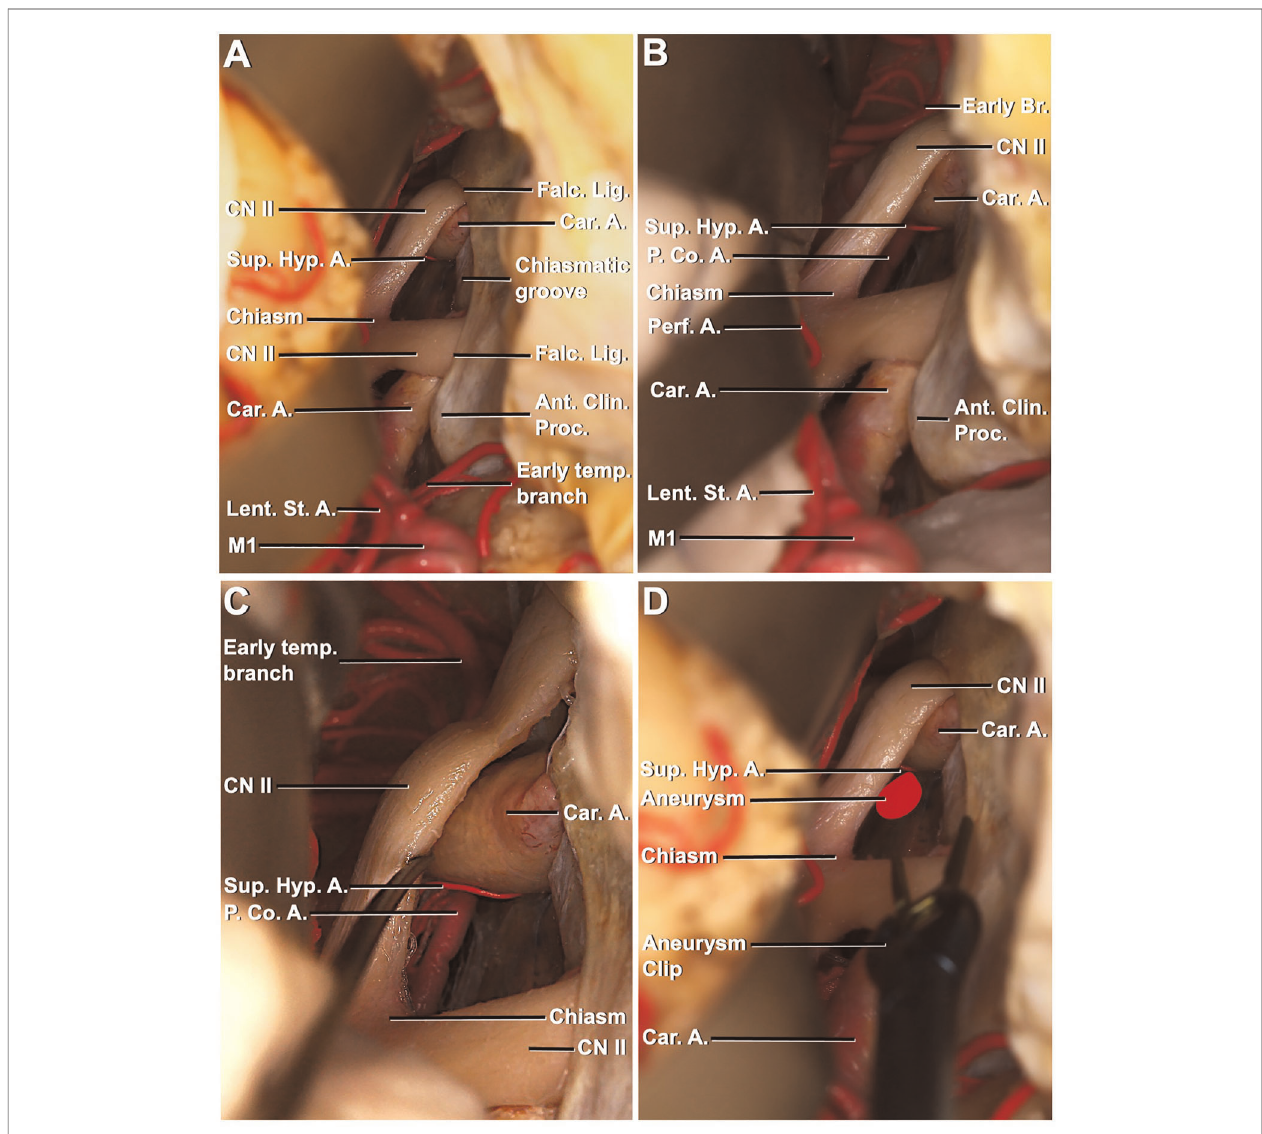
FIGURE 3 | Right pterional exposure of the preoptic chiasm and circle of Willis, contralateral approach to the left superior hypophyseal artery. ( A ) Right frontotemporal bone fl ap is elevated, and the dura is opened. The right frontal and temporal lobes have been retracted to expose the right carotid artery entering the dura medial to the anterior clinoid process. Right – left optic nerves, optic chiasma, prechiasmatic area, left carotid artery, and left superior hypophyseal artery are visible. ( B ) Exposure has been extended between the chiasm and frontal lobe to the left posterior communicating artery (PCoA) left superior hypophyseal artery arising from the ophthalmic segment. ( C ) PCoA, the course of the left superior hypophyseal artery, is exposed through left optic nerve mobilization. ( D ) Aneurysm of the left superior hypophyseal has been illustrated and approached with an aneurysm clip to mimic the contralateral surgical